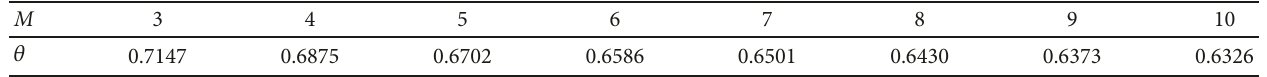
Table 5: Average values of θ